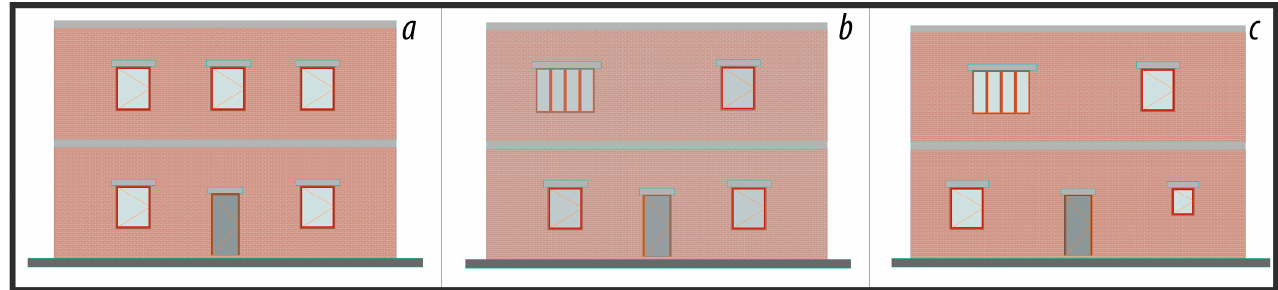
Figure 12. Vertical spacing irregularity: ( a ) Regular, ( b ) Less irregular, ( c ) Irregular.